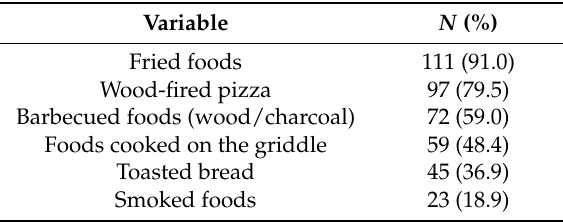
Table 3. Children who consumed foods subject to risky cooking methods in the month before the survey.